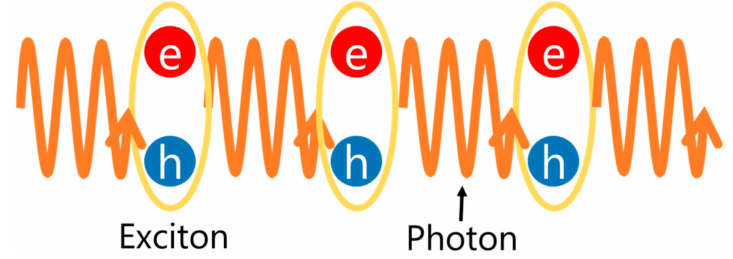
Figure 1. Schematic of an exciton-polariton.